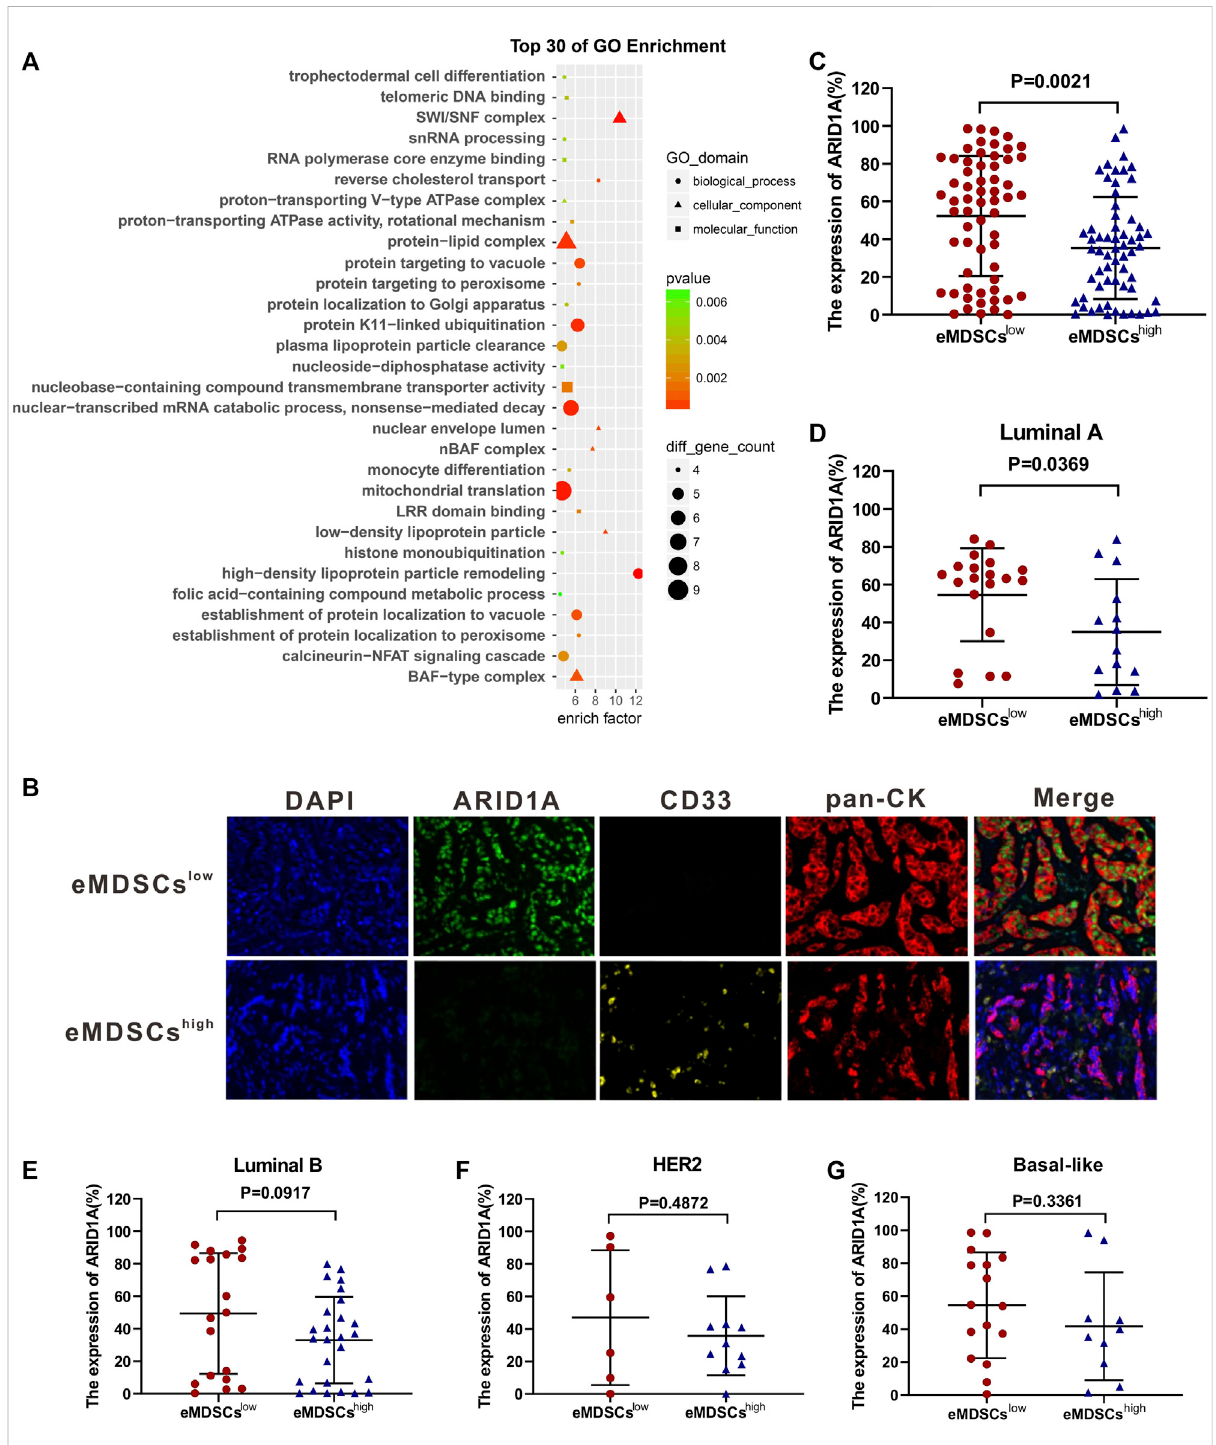
FIGURE 4 eMDSCs downregulate the expression of ARID1A in luminal A breast cancer cells (A) Gene ontology enrichment analysis of the strongest differential expressed proteins between eMDSCs high and eMDSCs low groups. (B) A multispectral IF staining assay showed that the changes of ARID1A expression betweeneMDSCs high andeMDSCs low groups in140primarybreastcancersamples fromcohort 1. (C – G) TheARID1A expression between different groups in (B) was